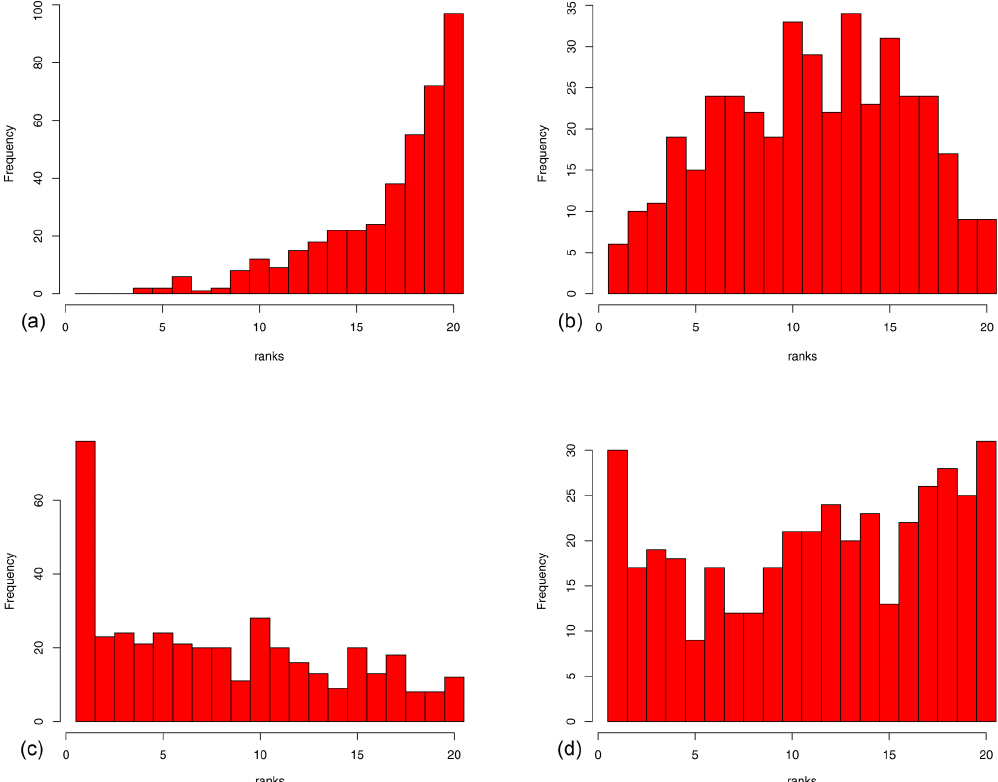
Figure 5. Rank histograms of data for four ensembles. (a) Biased ensemble with 2 × scaling. (b) Biased ensemble with 2 × scaling, after recentring. (c) Biased ensemble with 0.5 × scaling. (d) Biased ensemble with 0.5 × scaling, after